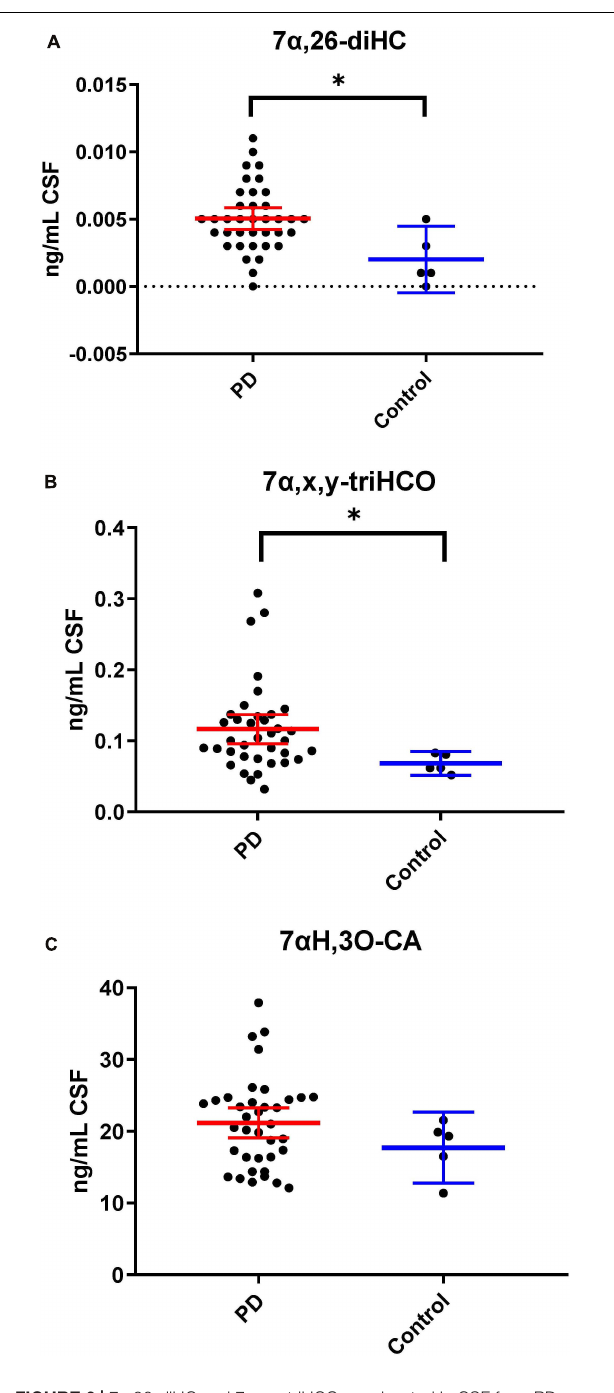
FIGURE 6 | 7 α ,26-diHC and 7 α ,x,y-triHCO are elevated in CSF from PD patients. (A) 7 α ,26-diHC. (B) 7 α ,x,y-triHCO. (C) 7 α H,3O-CA is also elevated numerically but the significance is lost when confounding variables of age and sex are considered. Data from Study 2.